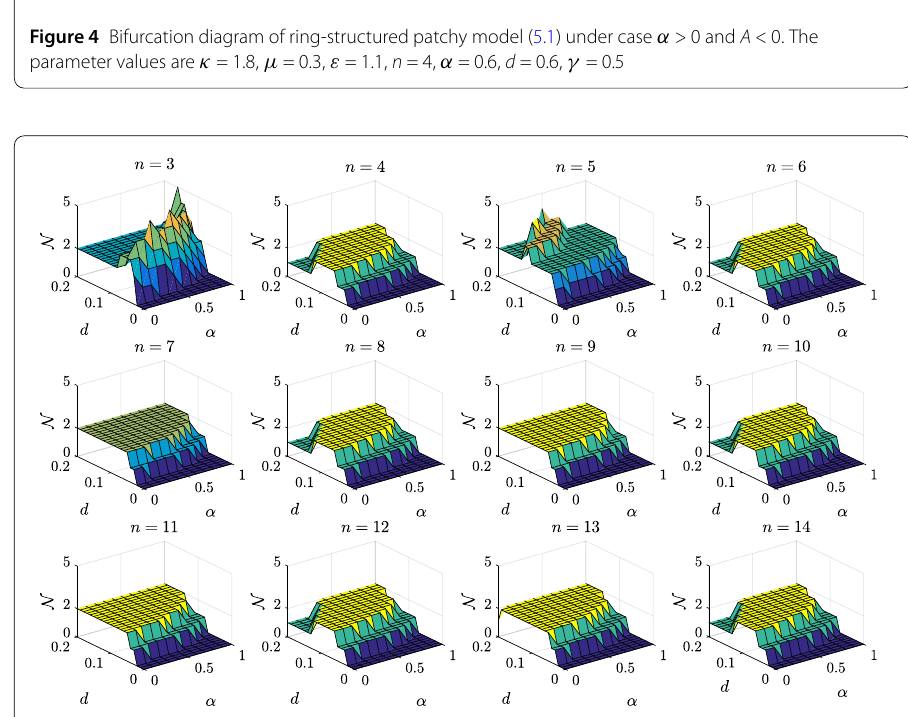
Figure 5 The number of stability intervals N against α , d and n for the ring-structured patchy model (5.1). The parameter values are κ = 2, μ = 0.2, ε = 1, γ =